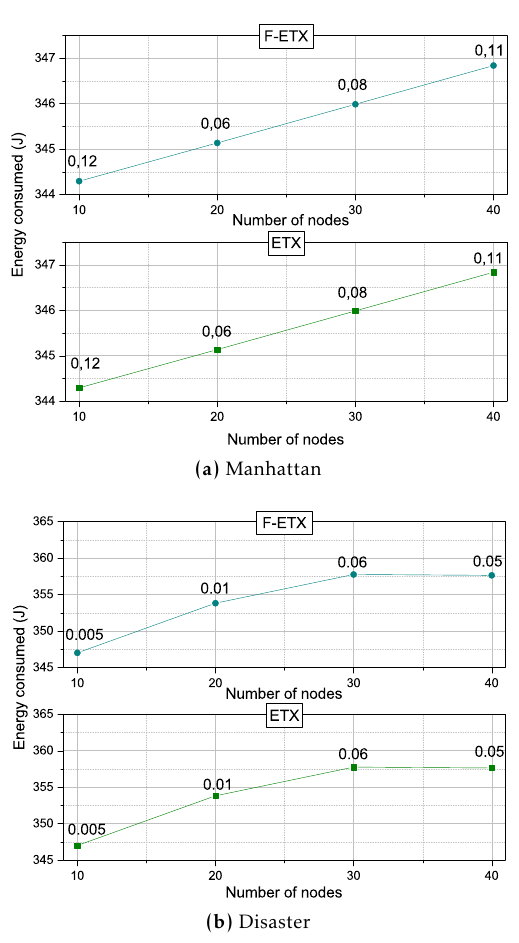
Figure 6. ETX vs F-ETX : Energy consumption to resist to transient variations (short-term). We assess the stability by computing the coe ffi cient of variation of the link quality estimation. It is defined as the ratio of the standard deviation to the mean. We computed this coe ffi cient on each link presents in the network. In this experiment, we have defined a maximum window size of 15 Sequence Numbers. The figure 7 depicts the coe ffi cient of variation of the couple of metrics.